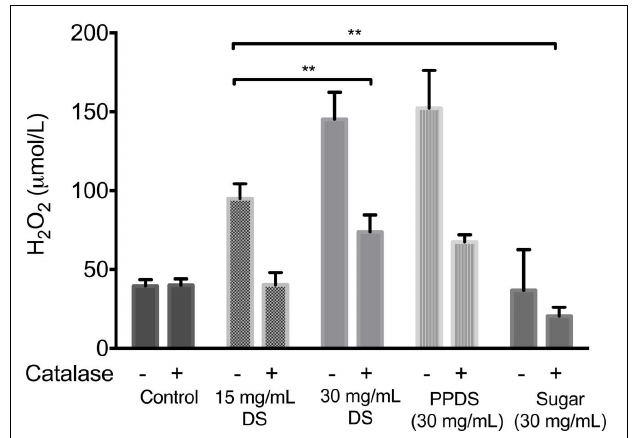
FIGURE 3 | H 2 O 2 generation by different sample treatments of DS, extracted DS polyphenols (PPDS), and artificial DS sugar (Sugar) and the effect of 100 U/mL catalase on the production of hydrogen peroxide by DS. The concentration of H 2 O 2 in the medium was immediately determined by the FOX method 1 h after the addition of different DS treatments to NB medium (pH7.5). Data is mean ± SD of three independent experiments. Significant differences between treatment groups are indicated as ∗∗ p < 0.01.